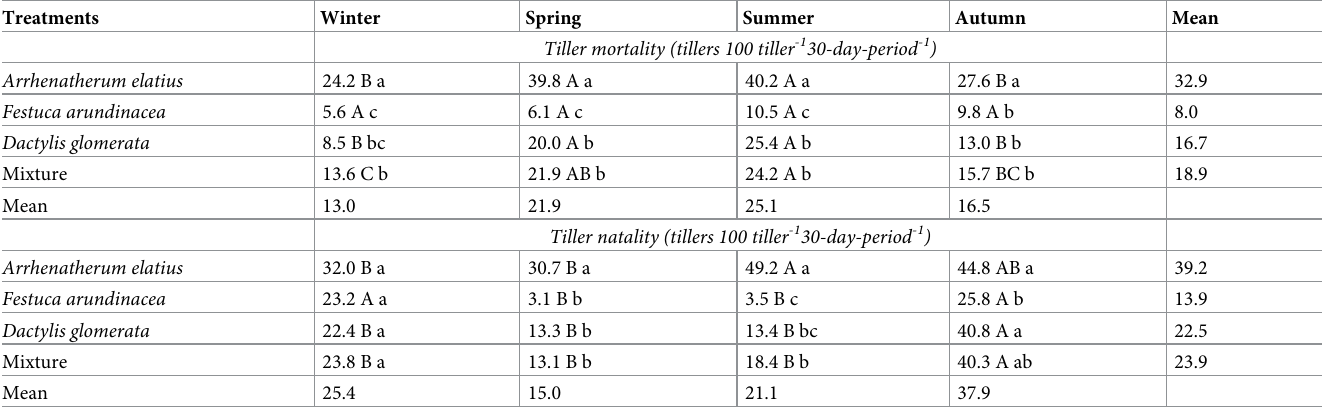
Table 2. Tiller mortality and tiller natality in Arrhenatherum elatius , Festuca arundinacea , and Dactylis glomerata swards sowed as monoculture or as a mixture throughout the seasons.